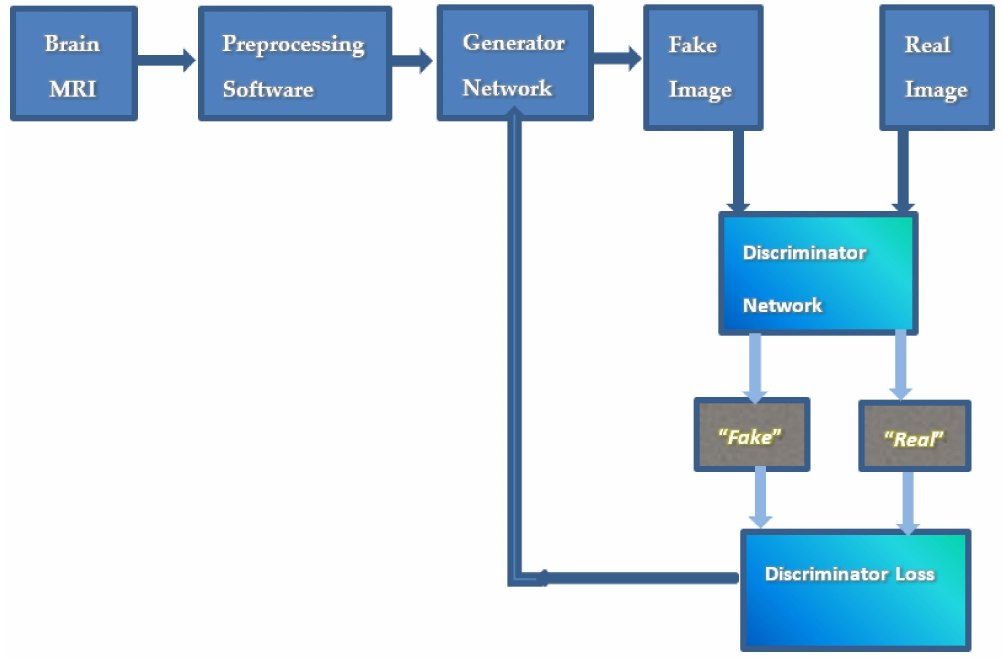
Figure 1. Block diagram for GAN-synthesized brain